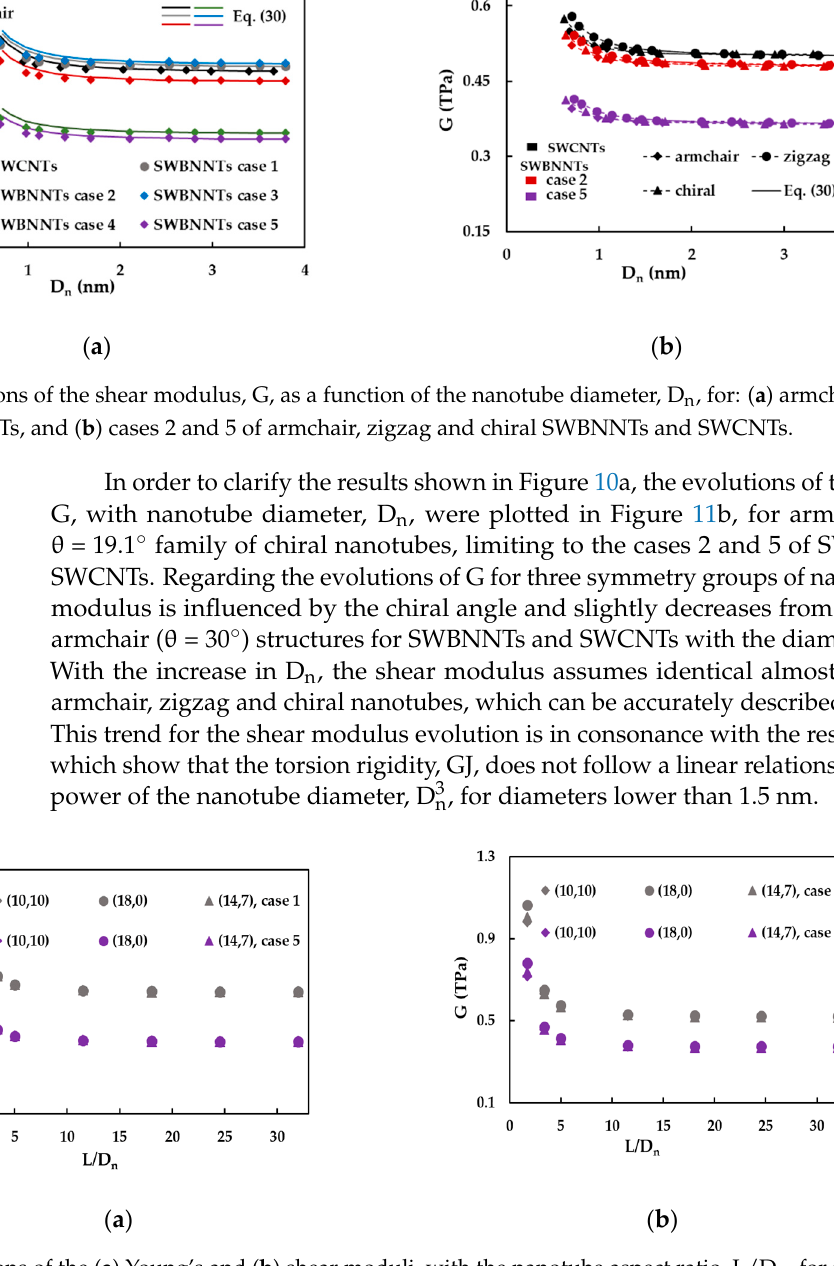
Figure 12. The evolution of the Poisson’s ration, ν , with the nanotube diameter, D n , for SWBNNTs. It can be concluded that, for nanotube diameters D n < 1.5 nm, the Poisson’s ratio clearly depends on the chiral angle and increases from zigzag ( θ = 0 ° ) to armchair nanotubes ( θ = 30 ° ) SWCNNTs. This result agrees with those of Figure 7b, which shows that the ratio EI/GJ, between bending and torsion rigidities, does not have a constant value, for the nanotube diameter, D n , below 1.5 nm. Table 7 summarises the results of the current study on Young’s, E, and shear, G, moduli and Poisson’ ratio, ν , of SWBNNTs, calculated using several combinations of the bond length and force-field constants, which provided five sets of the input parameters